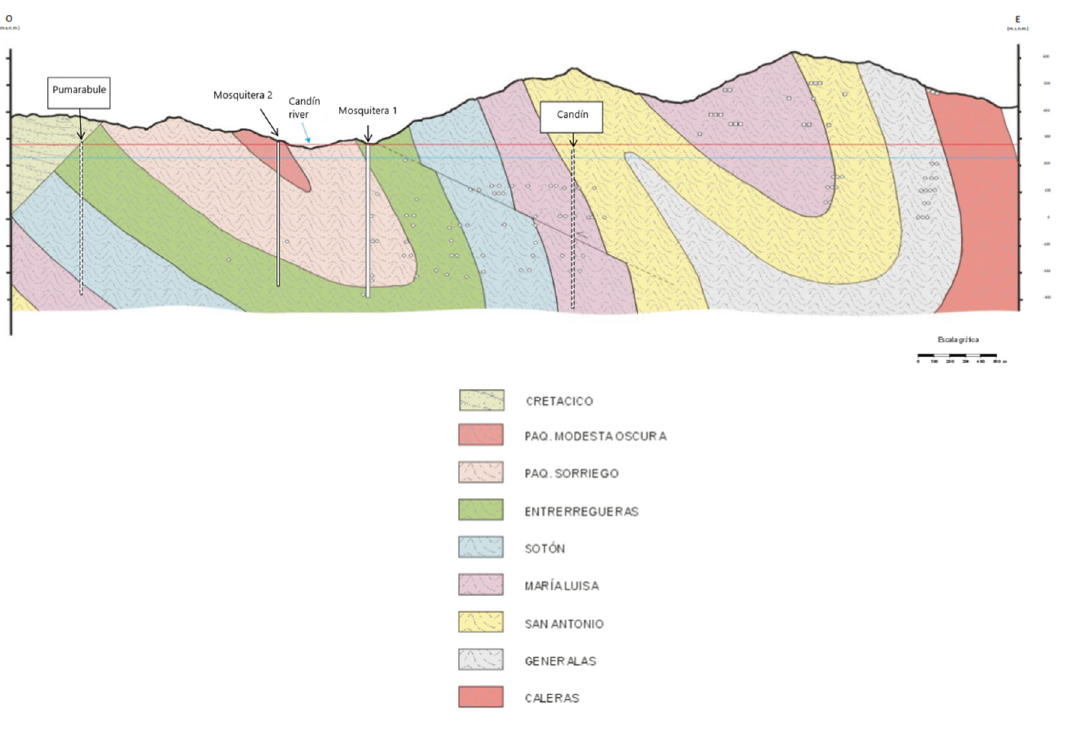
Figure 2. Geological section map of the two mines.